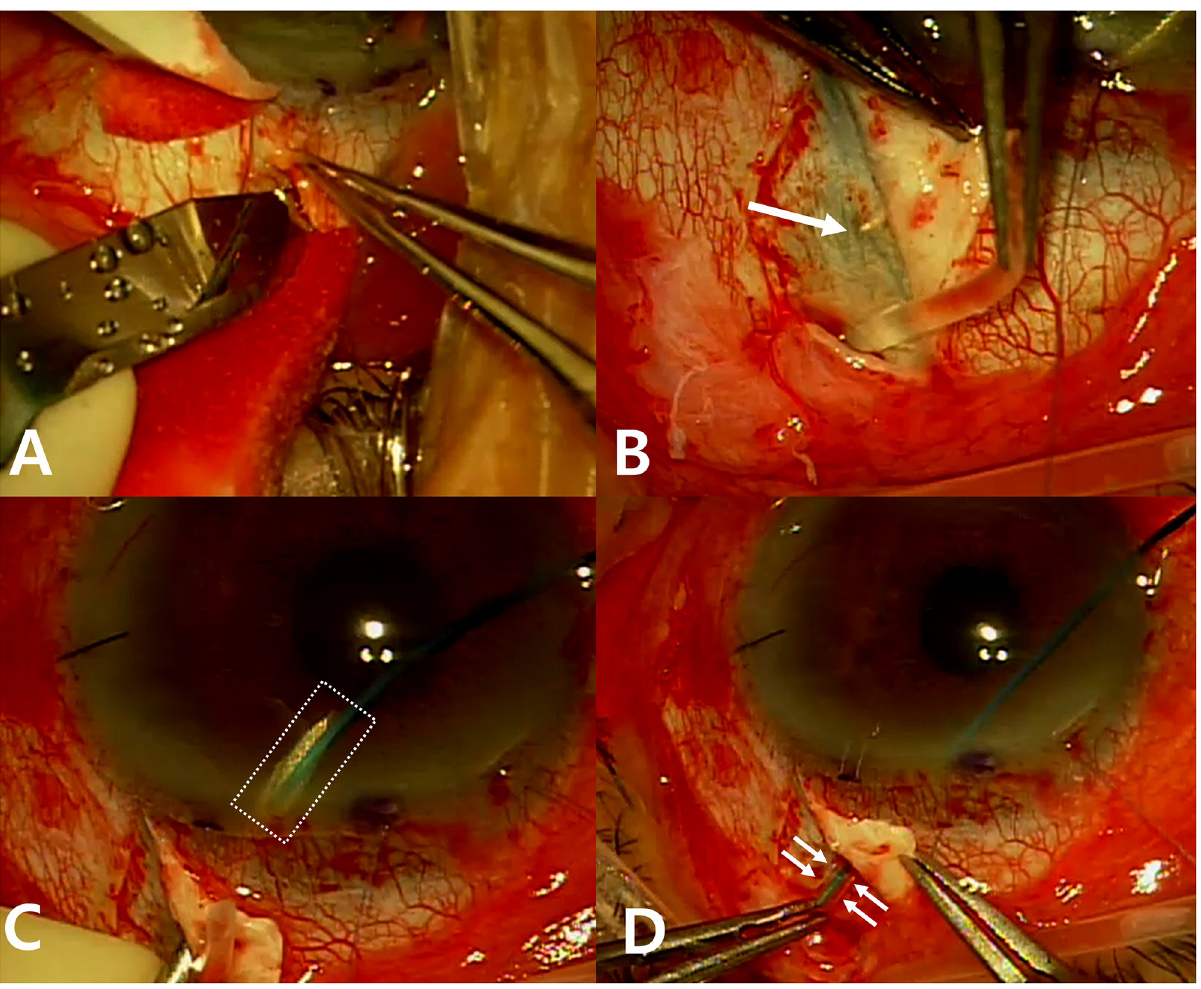
Fig 1. Intraoperative photographs showing the main steps in the process of guided tube insertion of Ahmed glaucoma valve (AGV). (A) Partial- thickness scleral flaps are made by scleral incision to prevent the tube from being exposed or out of position. (B) The spatula tip is gently rubbed to mark the insertion site under the scleral flap. The rubbed sclera becomes thin and transparent, revealing the spatula tip underneath (a white arrow). (C) Pre-cut 4–0 nylon with a diagonal cut end is docked into the 23G needle in the AC (a dashed white rectangle). (D) Once the 4–0 nylon is outside the eyeball, it is placed into the trimmed AGV tube, and the tube is gently inserted to the AC together with intraluminal nylon. Small white arrows indicate the tube boundary just before entering the sclerotomy site, and the 4–0 nylon stent is inside the tube. 8 mm posterior to the limbus. The tube was trimmed to an adequate length by using a bevel-